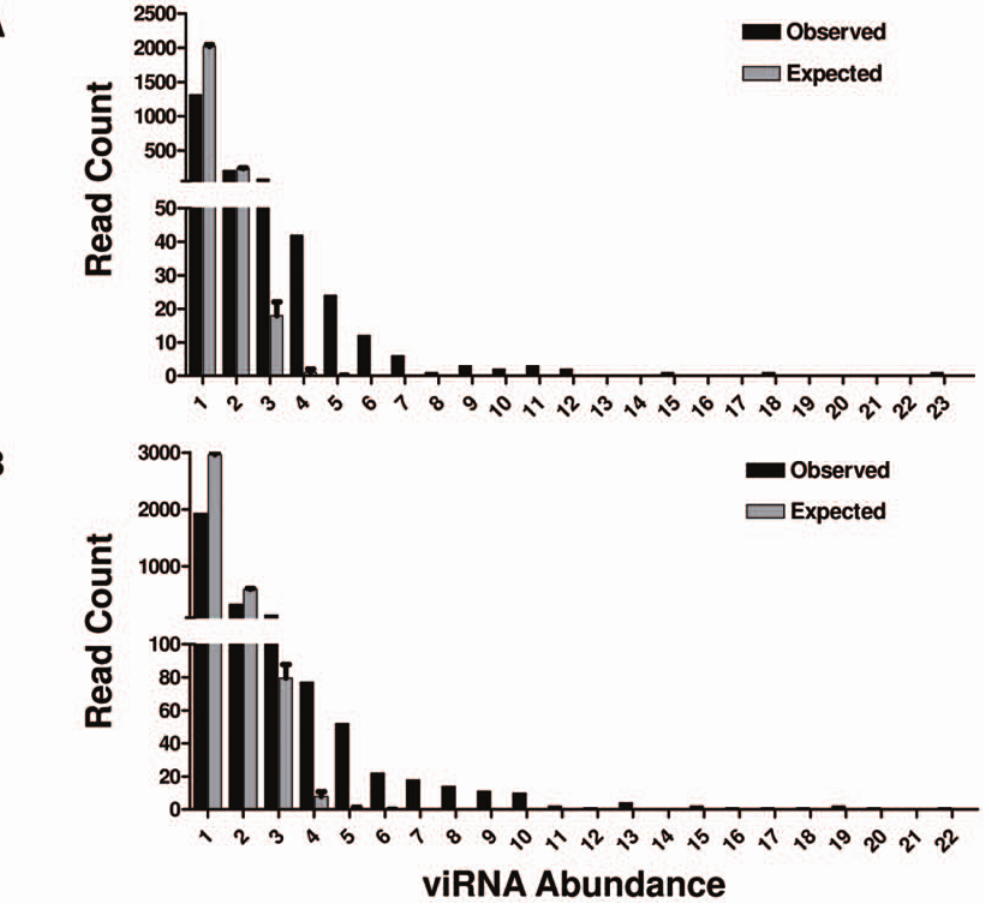
Figure 3. A Small Subset of viRNA Reads Is Highly Abundant. viRNA abundance observed at 7 (A) and 14 (B) days post infection (black bars) compared to the null expectation of equal abundance of all reads (grey bars). Expected values were obtained through permutation analysis with replacement sampling of n=2544 (day 7) or n=4419 (day 14) random genome positions. 100,000 permutations were conducted for each dataset. Expected and observed distributions of read abundances were statistically compared by the Kolmogorov-Smirnov test (P , 0.001 at both